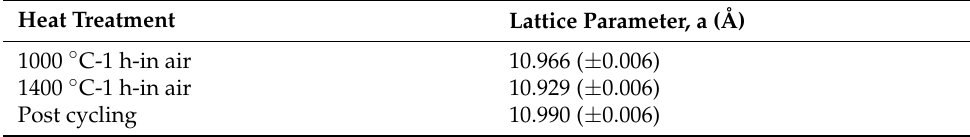
Table 2. Lattice parameter of HEO 3.